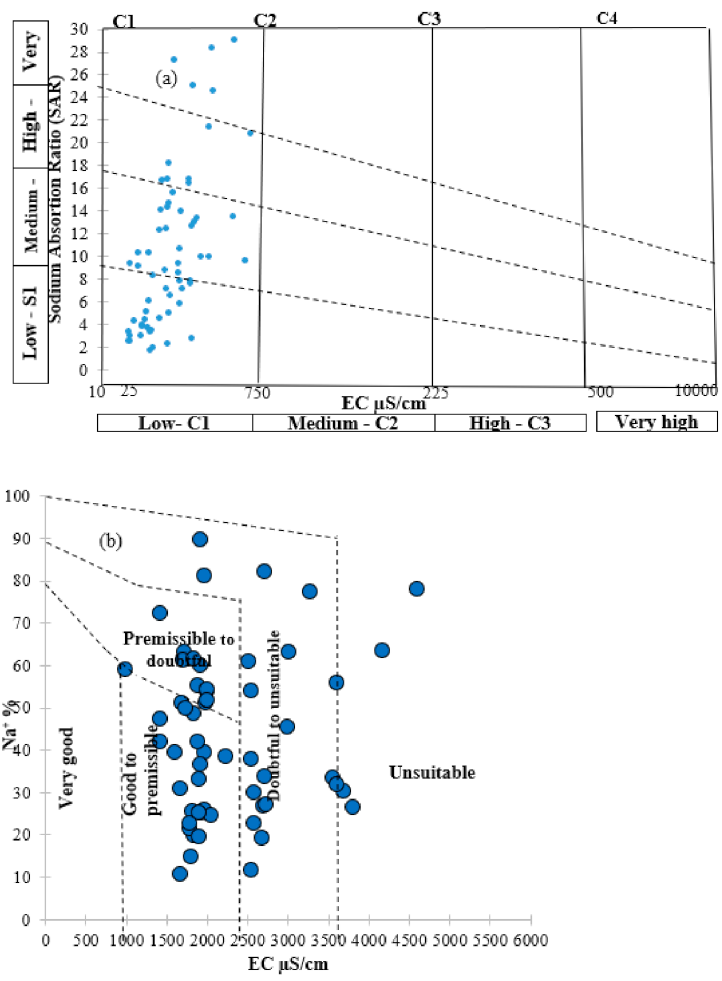
Figure 11. ( a ) Groundwater quality evaluation as sodium absorption ratio (SAR) vs. EC (uS/cm) with USSL diagram. ( b ) Wilcox diagram used for the classification of irrigation water, indicating %Na vs.